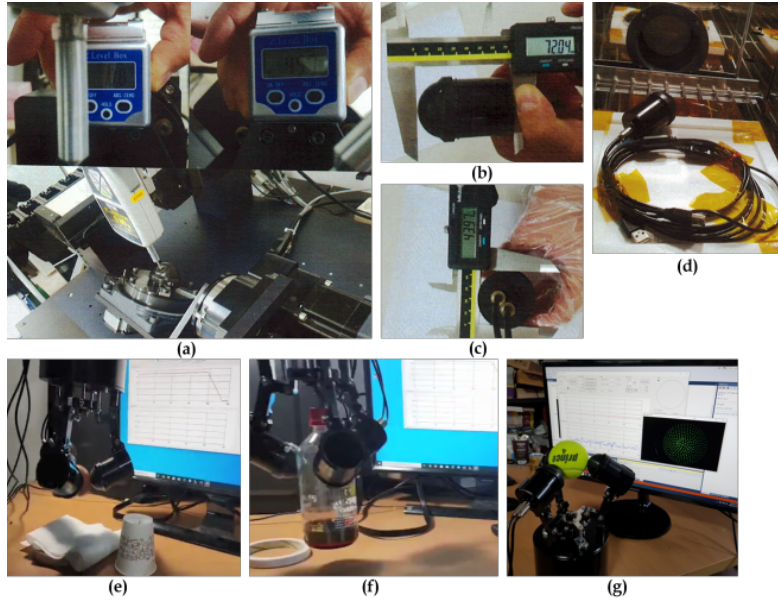
Figure A1. Tactile sensor-related aspects: ( a ) Stable calibration of tactile sensor at an angle of 45 ◦ . ( b ) Measuring the height of tactile sensor (72 mm) using vernier caliper. ( c ) Width of tactile sensor (44 mm). ( d ) Tactile sensor camera. ( e ) Vision-based tactile sensor used in a robotic arm grasping a raw egg. ( f ) Lifting and placing a bottle. ( g ) Grasping a tennis